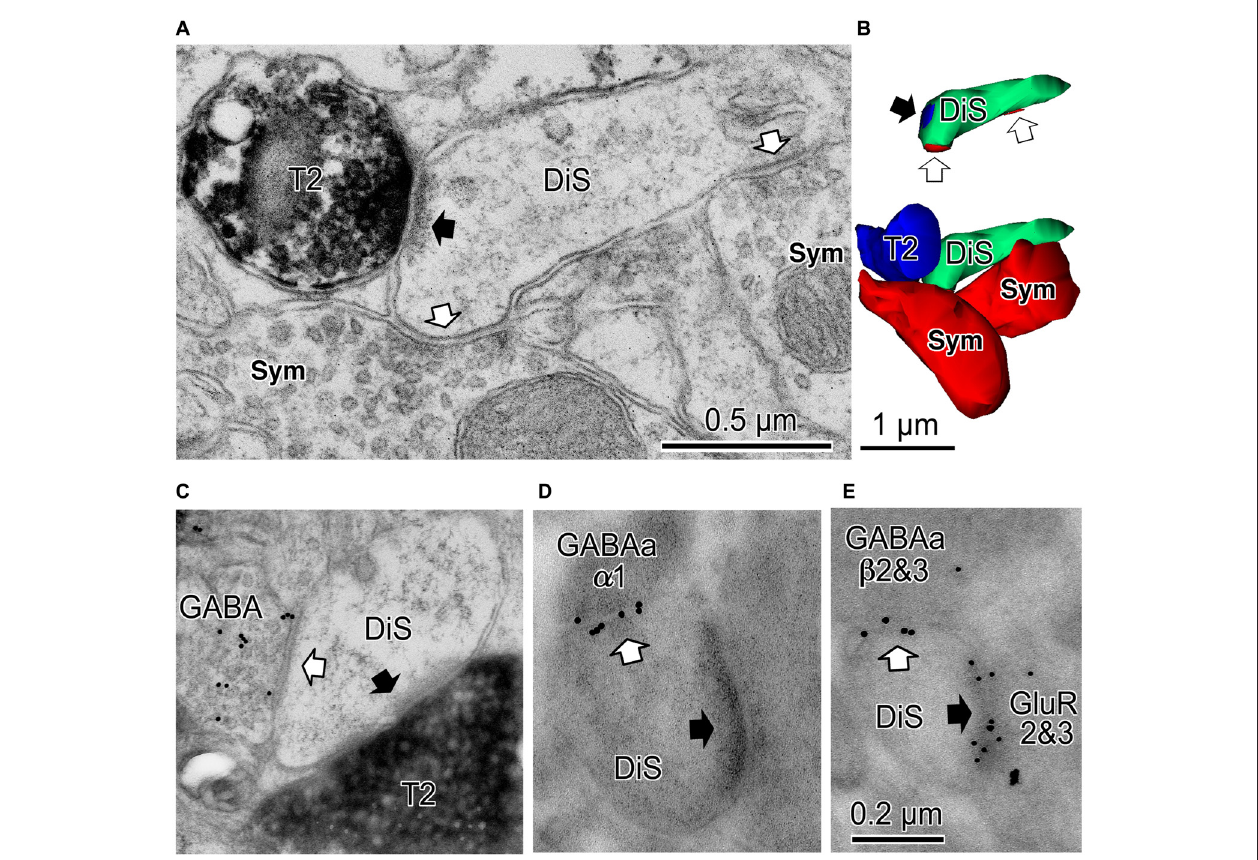
FIGURE 5 | Cortical dually innervated spines. (A) A cortical spine (DiS) was co-innervated by a vesicular glutamate transporter 2 (VGLUT2)-positive (T2) asymmetrical synaptic terminal (black arrow) and two symmetrical synaptic terminals (Sym) (white arrows). (B) 3D reconstructed image of the spine and presynaptic terminals shown in (A) . Bottom image is the VGLUT2-positive bouton (T2, blue) contacting the spine head (DiS, green) with a synaptic junction. This spine is also innervated by two symmetrical inputs (Sym, red). Upper image shows synaptic junctions (black arrow for VGLUT2 synapse (blue) and white arrows for symmetrical synapses (red)) on the spine head (DiS, green). (C) A spine head (DiS) innervated by both a VGLUT2-positive (T2) asymmetrical synaptic terminal (black arrow) and a GABA-positive (colloidal gold particle labeled) symmetrical synaptic terminal (white arrow). (D) A spine head (DiS) innervated by an asymmetrical synaptic terminal (black arrow) and also innervated by a symmetrical synaptic terminal (white arrow). Gold particles label GABA A α 1 receptor subunits localized along the synaptic junction of the symmetrical synapse. (E) A spine head (DiS) innervated by an asymmetrical synaptic terminal (black arrow) and also innervated by a symmetrical synaptic terminal (white arrow). Larger gold particles (15 nm) labeled GABA A β 2&3 receptor subunits localized along the synaptic junction of the symmetrical synaptic terminal and smaller particle (10 nm) labeled glutamate receptor GluR2&3 subunits of the associated asymmetrical synaptic junction. Scale in (C) shares the scale bar shown in (A) , and the scale in (D) is the same as shown in (E) . Adapted from Kubota et al.